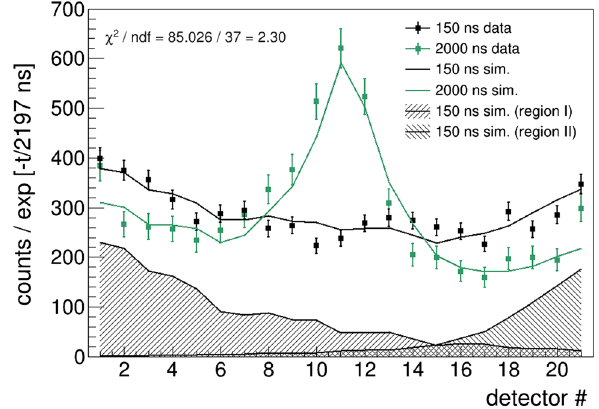
Fig. 5 Measured (dots) and simulated (curves) positron hits in the 21 scintillators shown in Fig. 2, for t = 150 ns and t = 2000 ns. The center-to-center distance between two adjacent scintillators is 10 mm. The simulated data are the same as in Fig. 3, but convoluted with the geometrical acceptance of the detectors. The width of the peak at t = 2 µ s is due to the large geometrical acceptance of the 21 scintillators and does not reflect the width of the muon swarm directly (compare with Fig. 3). The shaded areas show the simulated contributions to the positron hits from muons stopped in regions I and II. The data and the simulations have been corrected for the finite muon lifetime by multiplying the counts by e t / 2197